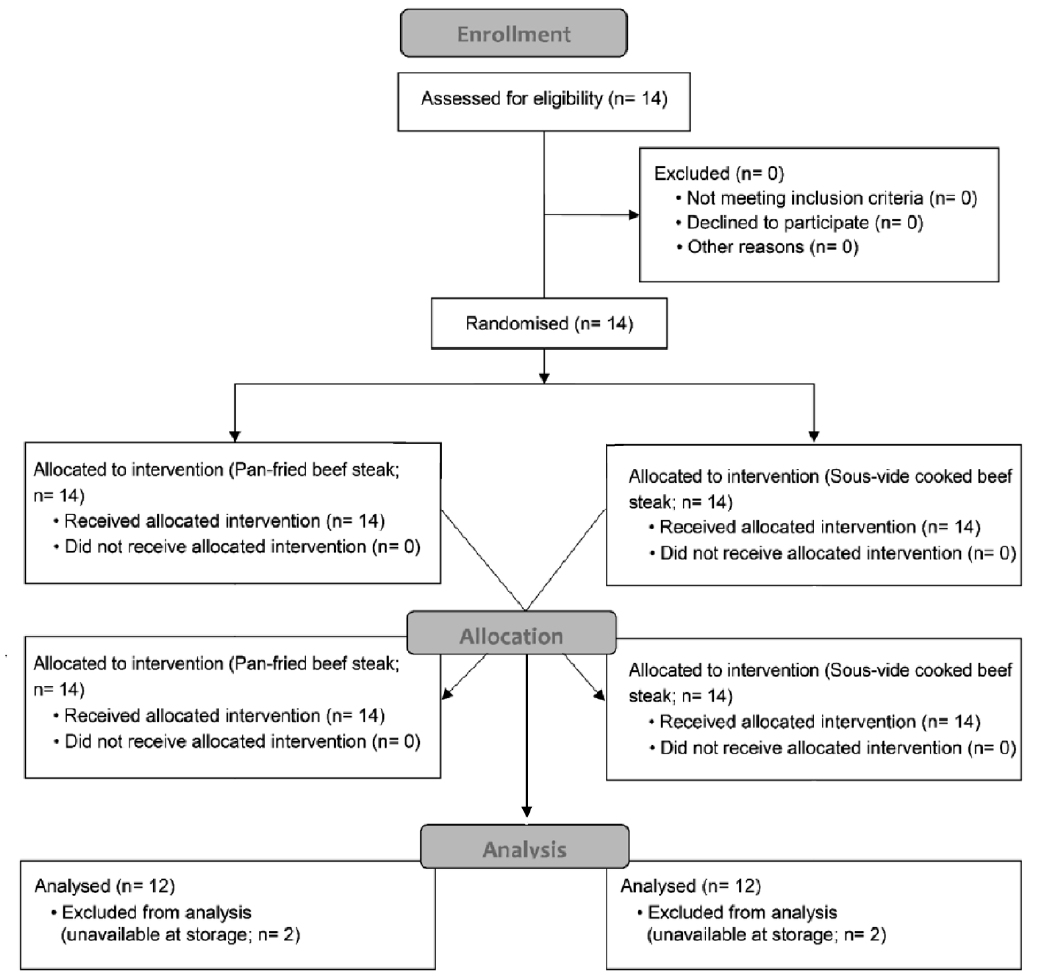
Figure 1. Consolidated Standards of Reporting Trials (CONSORT) diagram of the study participants from enrollment, allocation and sample analysis.